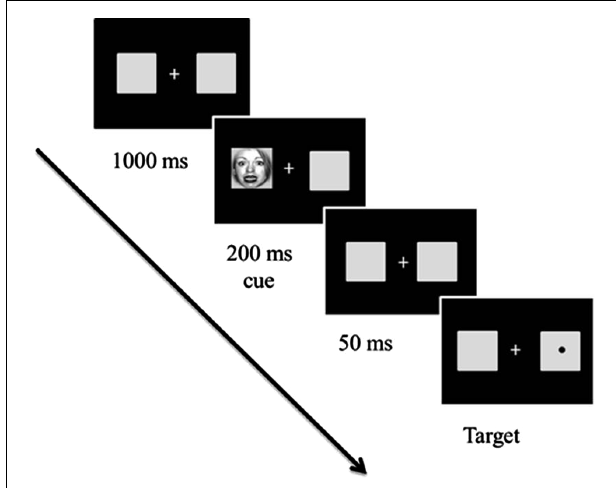
FIGURE 3 | Sample trial in Experiment 1 from Park etal. (2013b). The cues and targets were equally likely to appear on the right or left of fixation. However, 80% of trials were valid (96 trials) and 20% of the trials were invalid (24 trials).The initial fixation display appeared for 1000 ms.Then, cues, which were either fearful or neutral faces created at broad, high, and low spatial frequency, appeared for 250 ms. After a 50 ms delay with the initial fixation display, a target circle appeared in the center of the left or right box until the participant responded (or until 2,000 ms elapsed). Stimuli are not drawn to